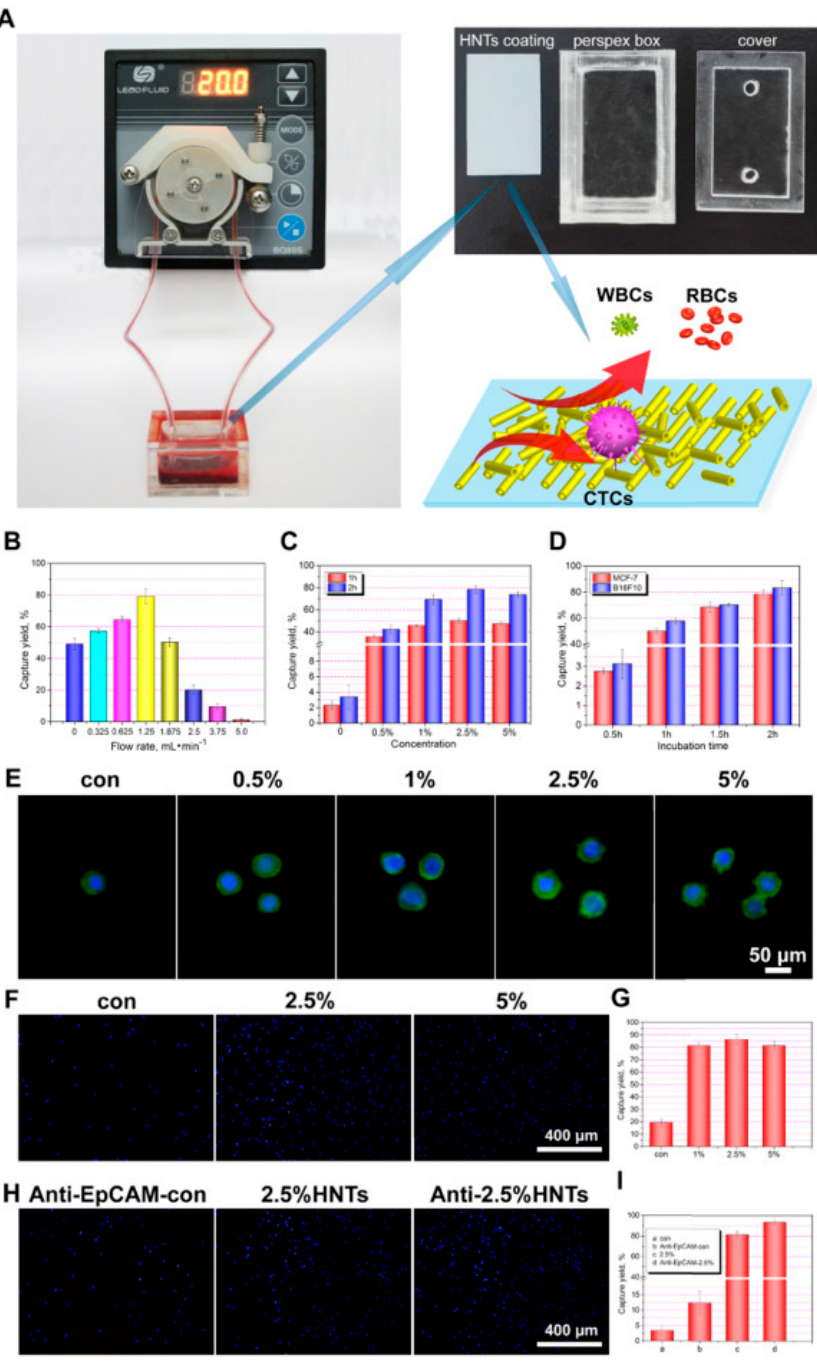
Figure 5. The photo of a circulating device with a peristaltic pump and the schematic diagram of cell capture from whole blood ( A ). The capture yield to MCF-7 cells with different flow rate ( B ). The capture yield to MCF-7 cells with different rough HNTs coating surfaces ( C ). The capture yield to MCF-7 cells at different times ( D ). The Alex Flour 488 and DAPI stained fluorescence microscopy images of captured cells of MCF-7 on the different coatings for 2 h ( E ). The DAPI stained fluorescence microscopy images showing that the MCF-7 cells captured by different coating surfaces under dynamic shear conditions for 1 h and then standing for another 2 h ( F ) and quantification of the captured MCF-7 ( G